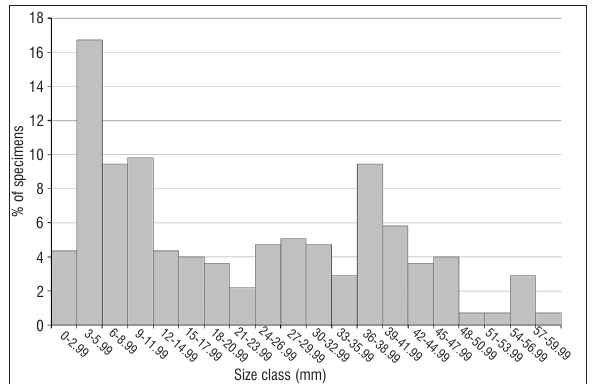
Figure 3: Size class distribution ( n =275) of Meretrix morphina in Lake St Lucia in November 2015.